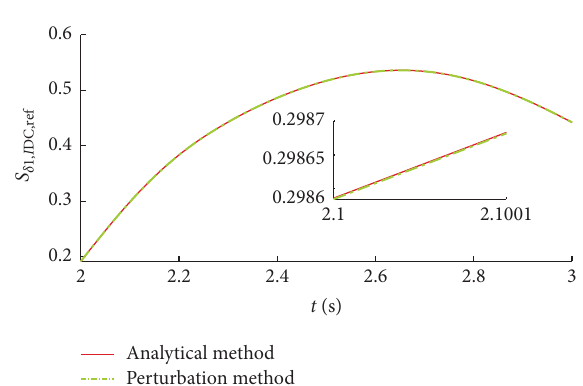
Figure 7: Trajectory sensitivity of the power angle of #1 SG to I DC,ref .